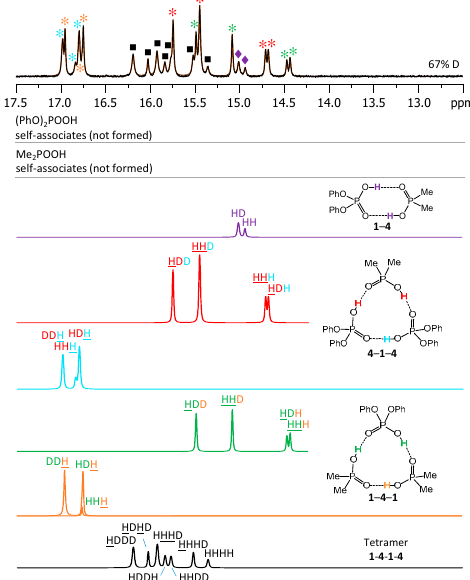
Molecules 2020 , 25 , x FOR PEER REVIEW 10 of 17 The low-temperature 1 H - NMR spectrum of samples containing a partially deuterated mixture of acids 1 with 4 is shown in Figures 10. At the very bottom of Figure 10 the deconvolution of the experimental spectrum gives seven extra signals, which are addressed in the Discussion. The Figure 9. The low-field part of the 1 H - NMR spectrum of the sample containing partially deuterated Figure 5. The low-field part of the 1 H-NMR spectrum of the sample containing partially deuterated 1 H - NMR spectra of some other mixtures of the partially deuterated acids ( 2 with 3 and 3 with 4 ) are (OH/OD, 57% D) acids 1 and 2 (1:1) in solution in CDF 3 /CDF 2 Cl at 100 K. The experimental spectrum (OH / OD, 57% D) acids 1 and 2 (1:1) in solution in CDF 3 / CDF 2 Cl at 100 K. The experimental spectrum shown in Supporting Information in Figures S8 and S9. The resulting list of chemical shifts is given is deconvoluted into the sub-spectra arising from various isotopologs of self-associates, heterodimer is deconvoluted into the sub-spectra arising from various isotopologs of self-associates, heterodimer in Tables 1 and 2. We did not manage to obtain the resolved spectra of mixtures of partially and heterotrimers. For visual clarification the signals in the experimental spectrum and the and heterotrimers. For visual clarification the signals in the experimental spectrum and the computed deuterated acids 1 with 3 and 2 with 4 , so this information is missing in Tables 1 and 2. computed sub-spectra are color coded. Trimers and dimers are marked by asterisks and diamonds, sub-spectra are color coded. Trimers and dimers are marked by asterisks and diamonds, respectively. respectively.